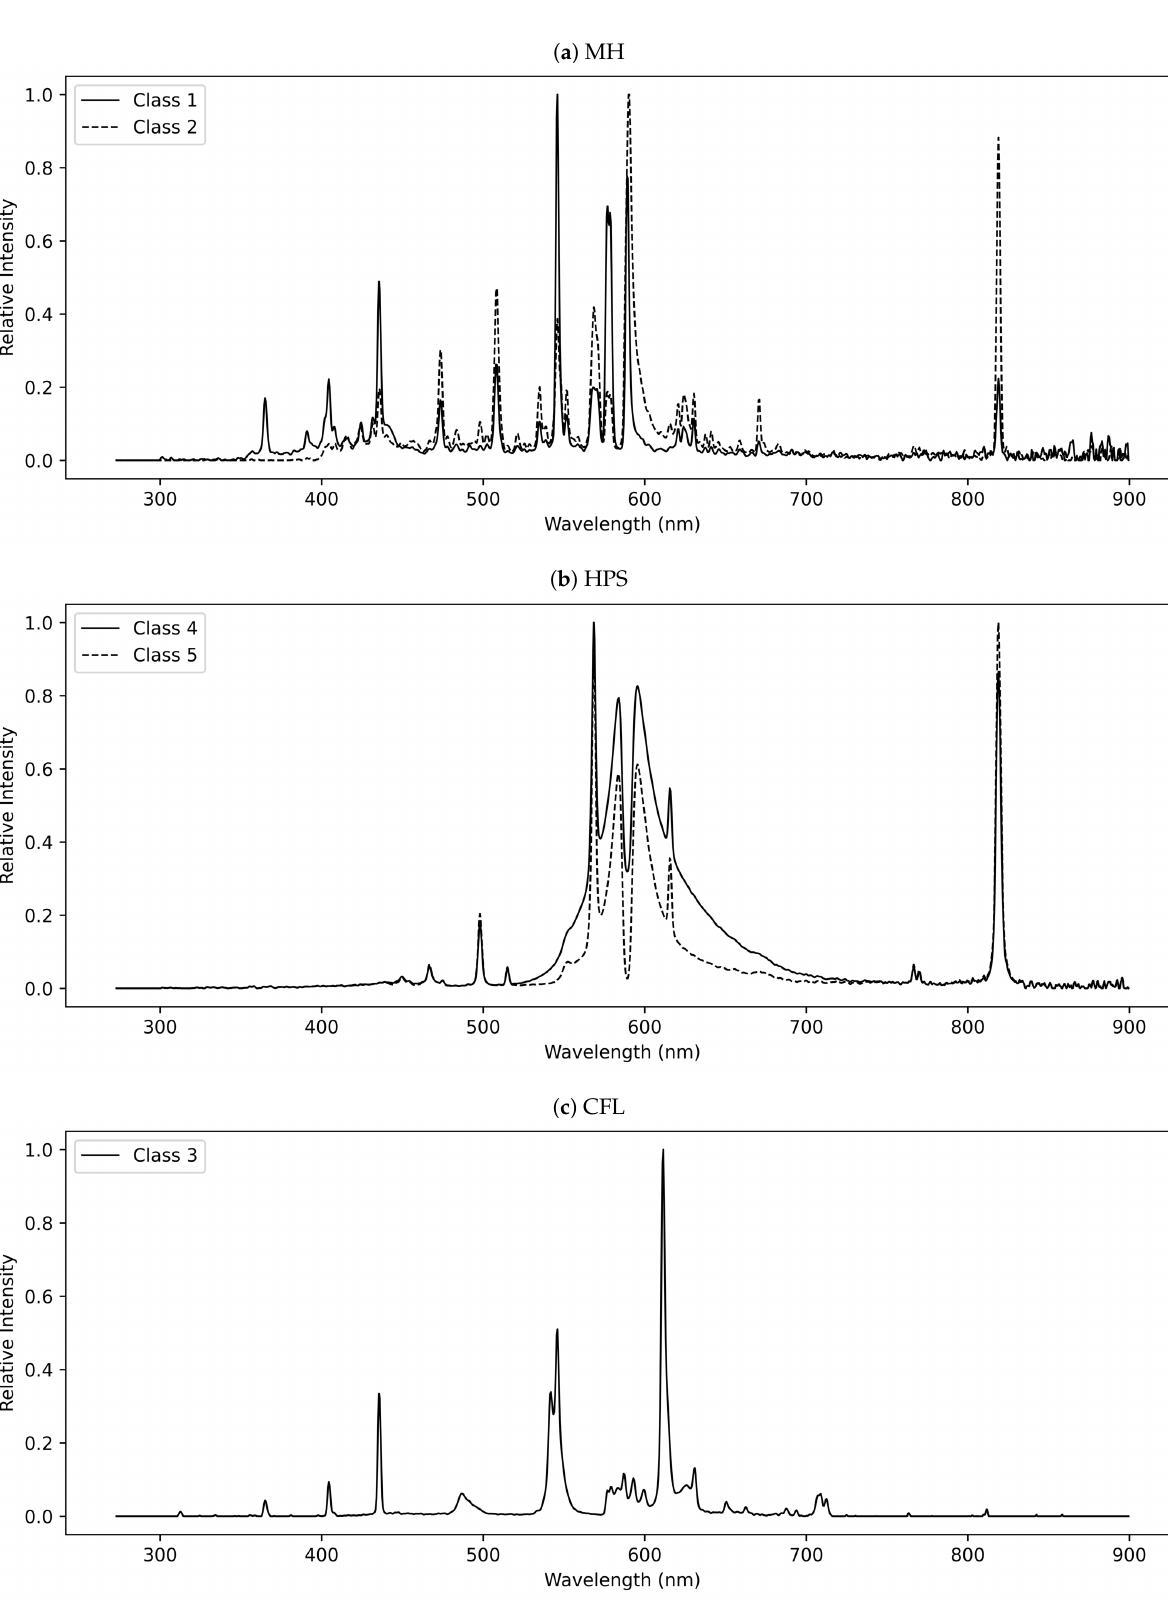
Figure 6. Spectra used for the modeling of Montréal in 2013. Panel ( a ) show the Metal Halides lamps spectra, panel ( b ) the High Pressure Sodium lamps spectra and panel ( c ) the Compact Fluorescent lamp